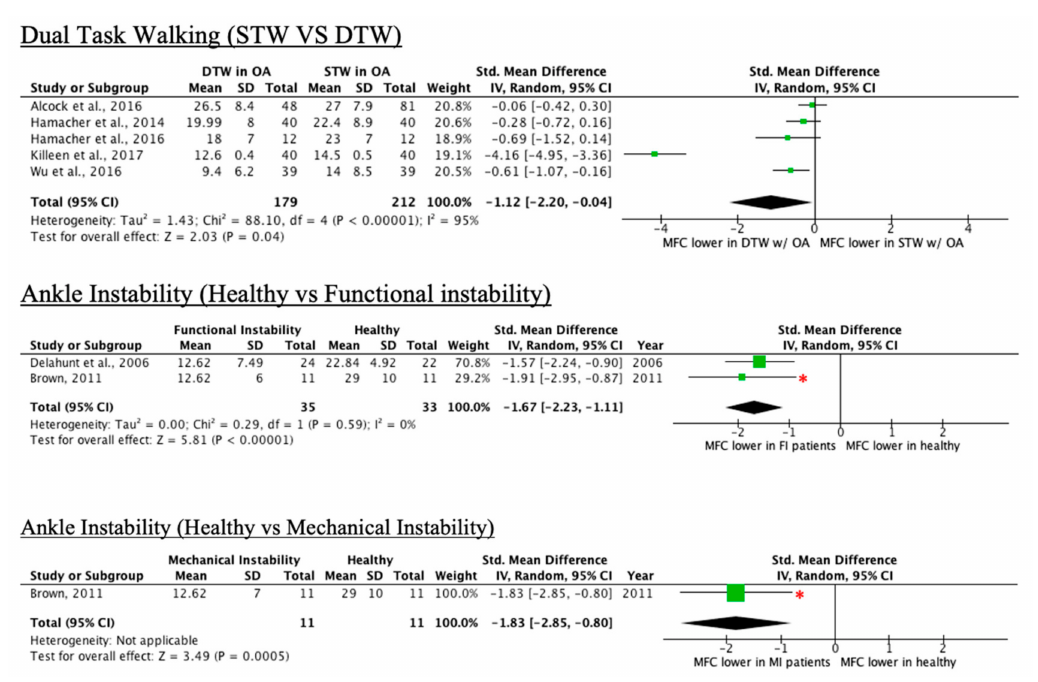
Figure 7. Forest plots of conditions comprising two or more studies with a decrease in MFC mean effect relative to control (* = original manuscript reports different finding; STW = single-task walking, DTW = dual-task